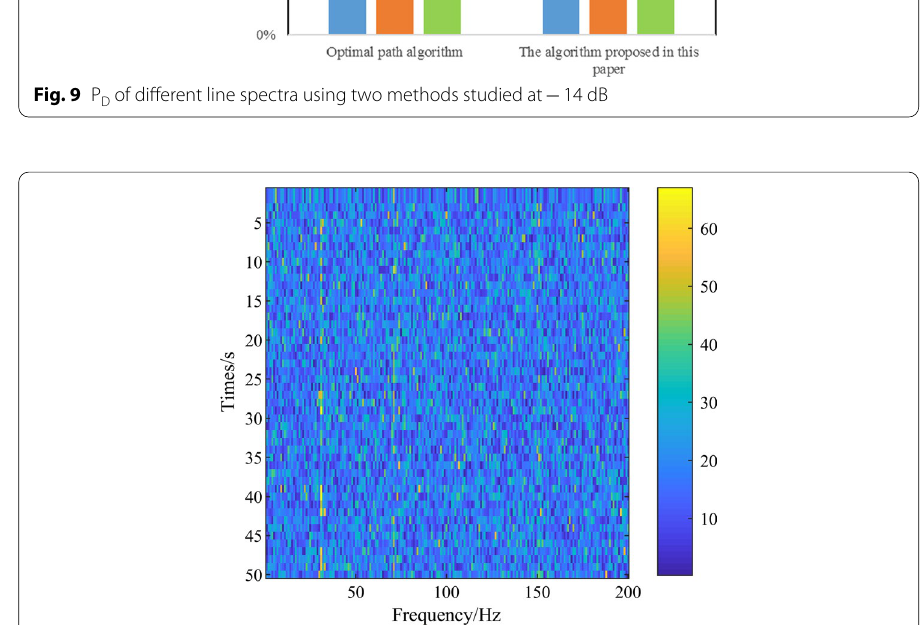
Fig. 10 Original lofargram at signal-to-noise ratio of